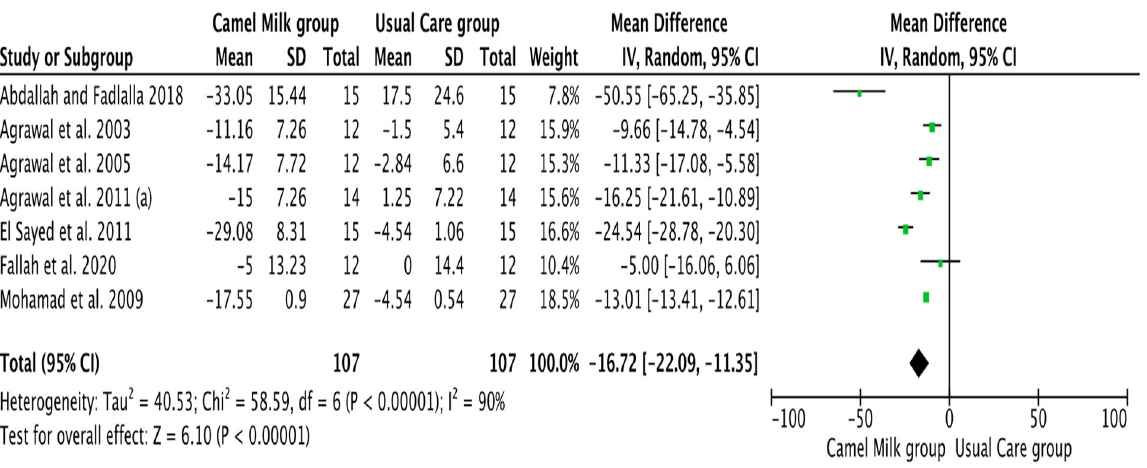
Figure 3. Forest plot for the effect of CM intake on insulin dose (ID). (a): difference between the two articles that are published by same author (Agrawal), same year.